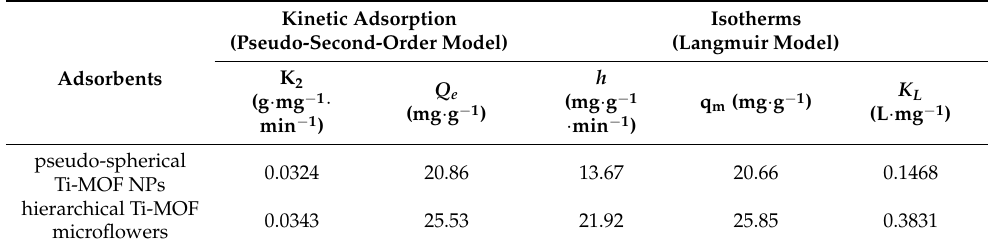
Table 1. Adsorption parameters of Al(III) on both type of